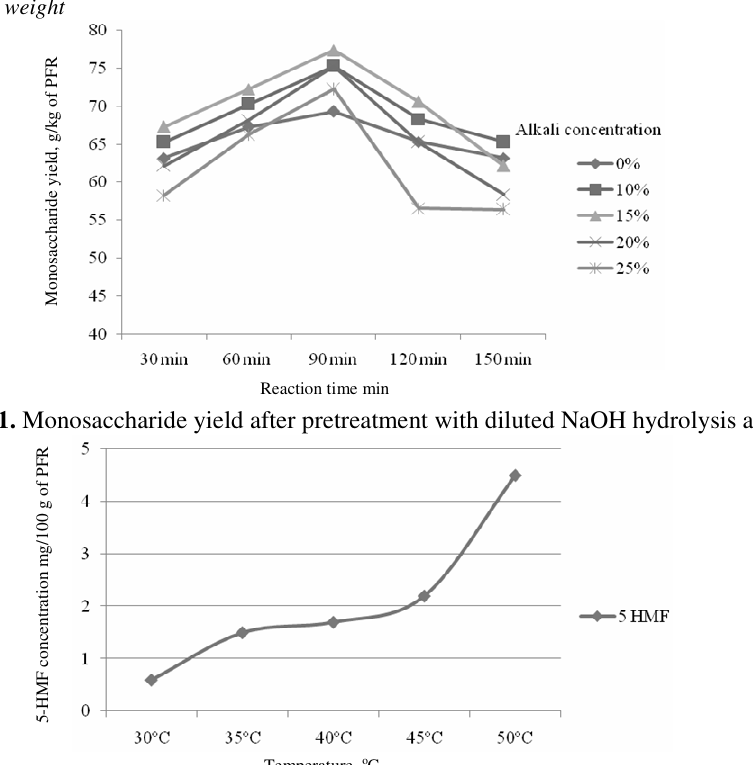
Figure 2. Yield of furfural obtained from hydrolysis of PFR at different temperatures. 10% w/w of NaOH was used and the residence time was 90